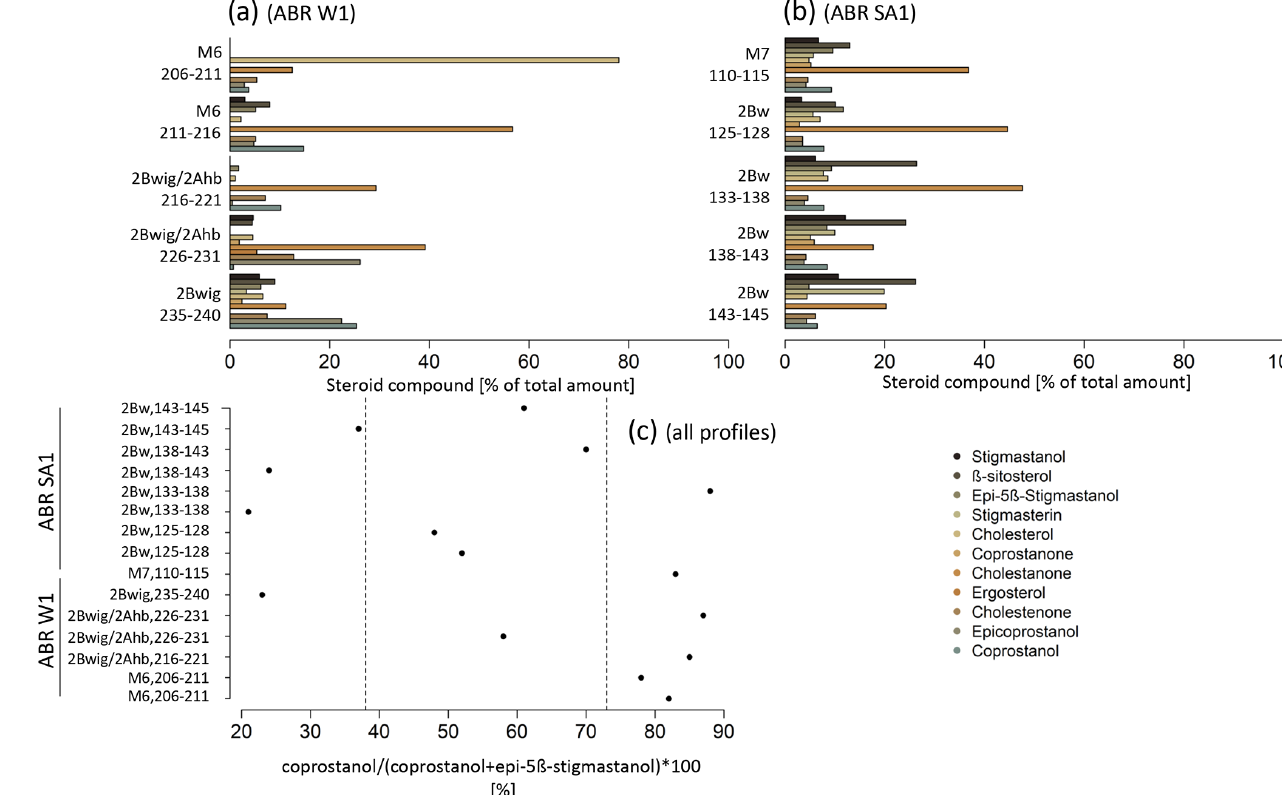
Figure 11. Steroid compounds as percent of total amount (a–b) of selected colluvial profiles and sampling depths (cm). Steroid ratio according to Leeming et al. (1997) (c) . Values < 38% indicate herbivorous faeces; values > 73% indicate omnivorous faeces.